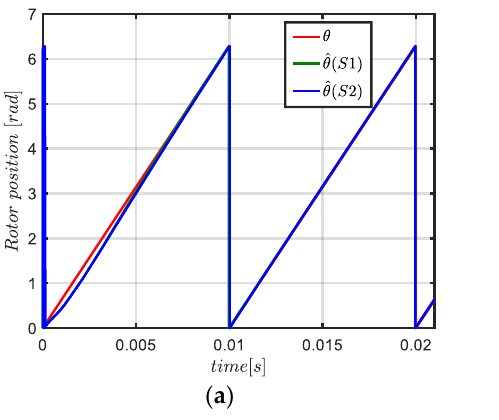
(b) Figure 21. Simulation waveforms at 78 rad/s of position errors resulting from ( S1 ) and ( S2 ): ( a ) error on the angle required to control MM, ( b ) error on the angle required to control SM. ( a )